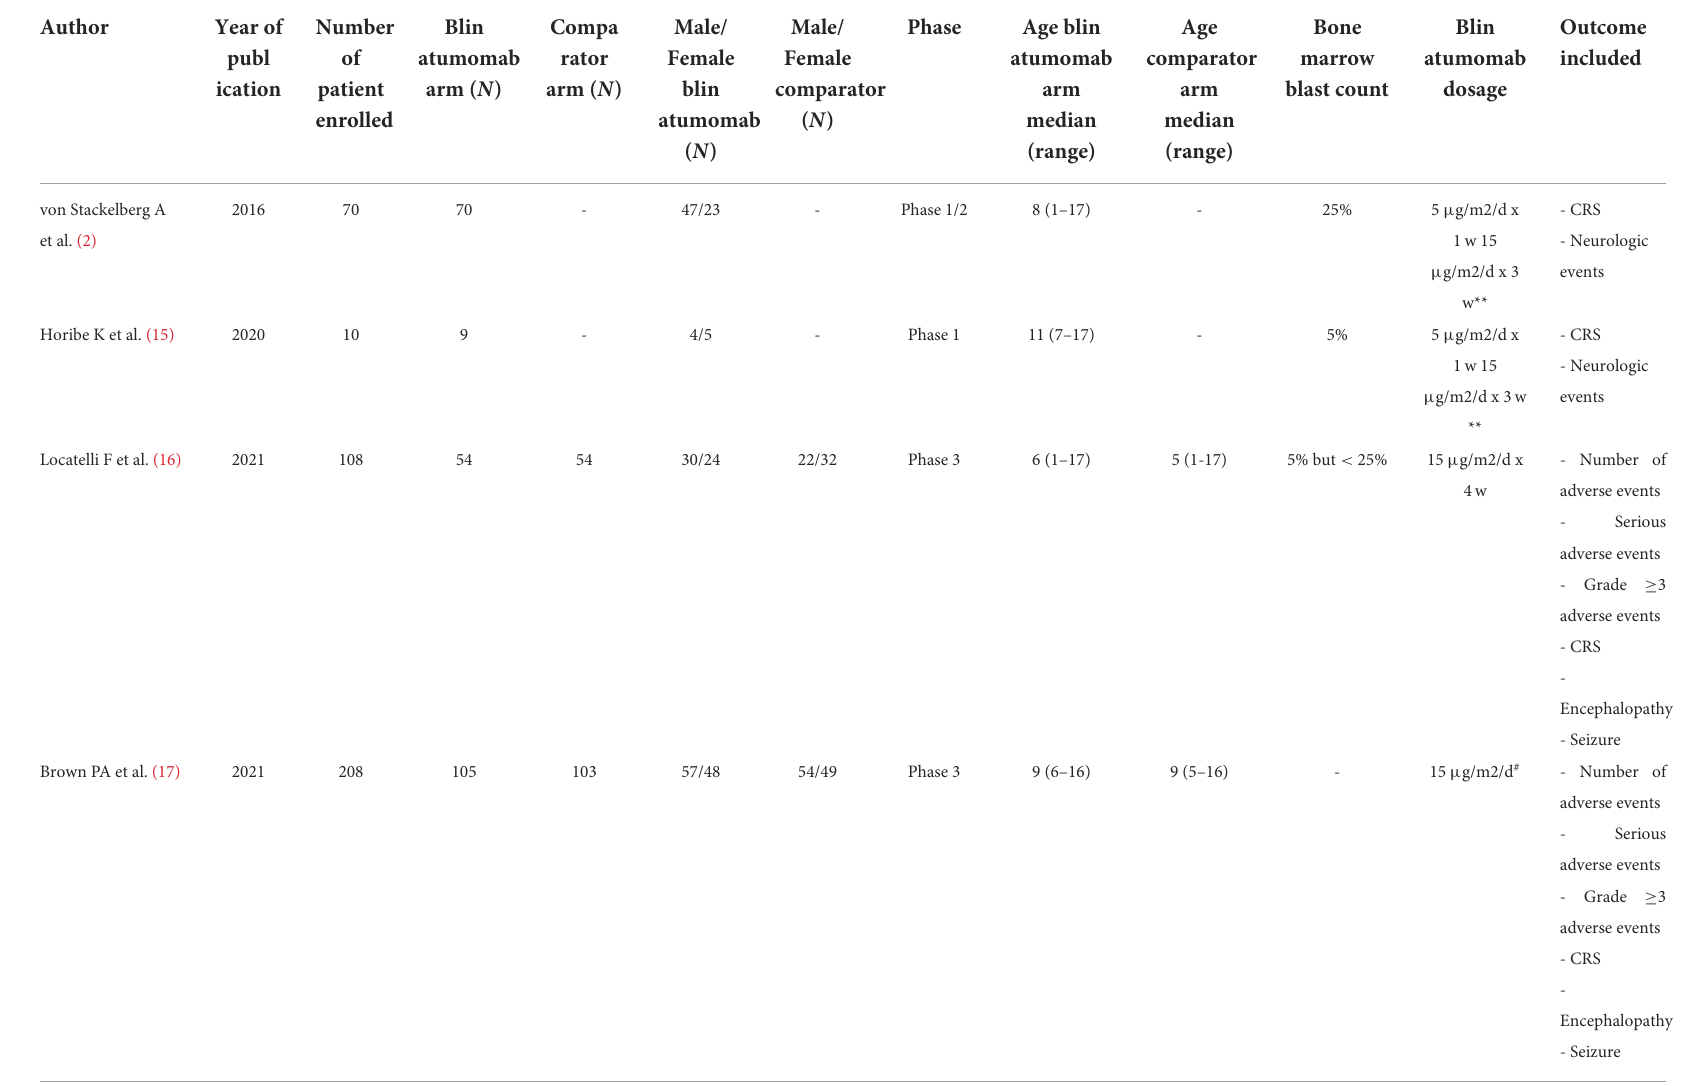
TABLE 1 Characteristics of pediatric clinical trials on